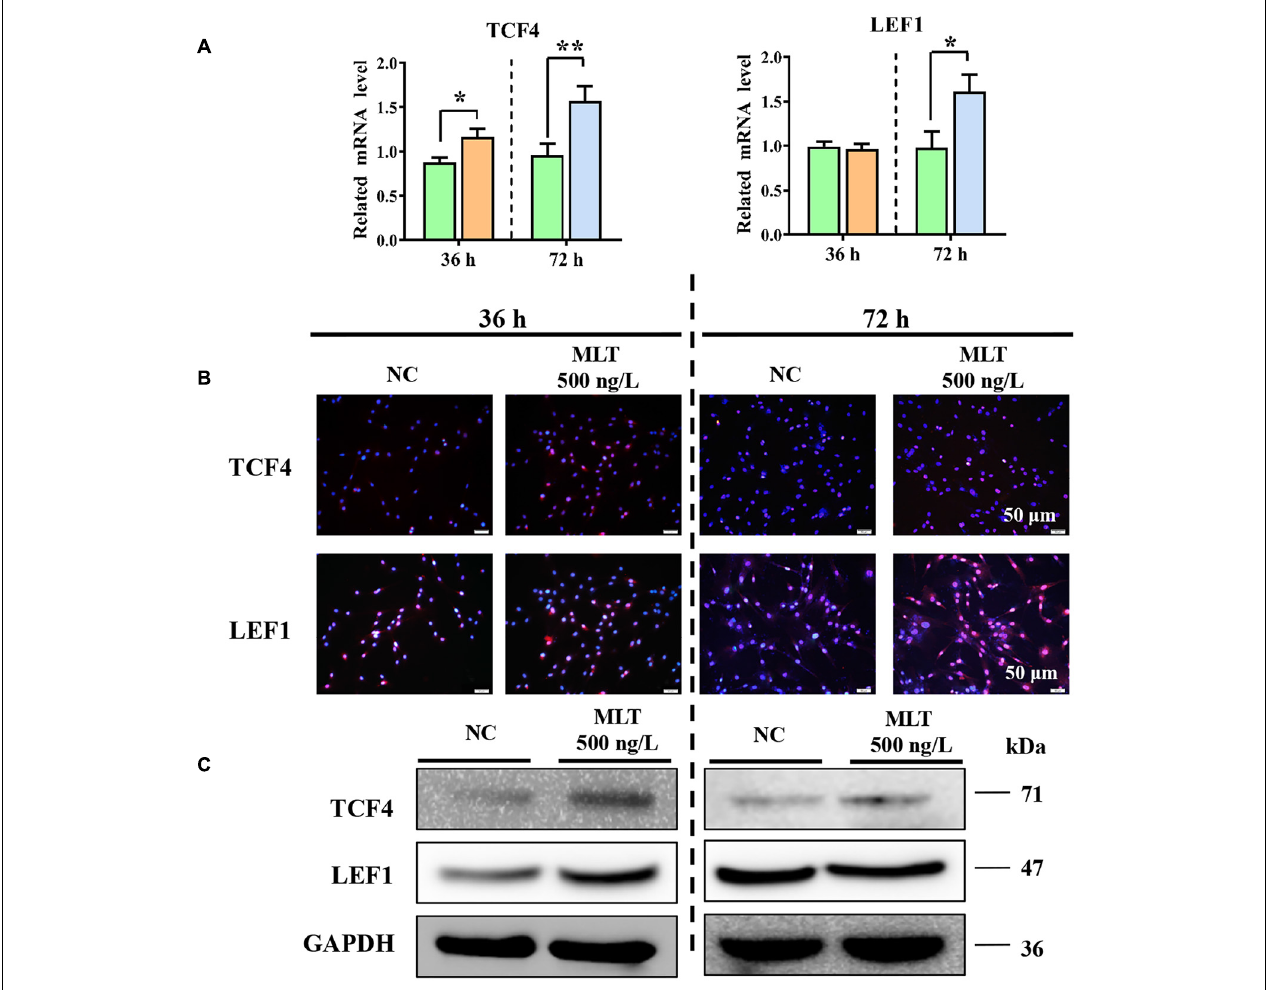
FIGURE 3 | Melatonin promoted the expression of Wnt downstream factors in gsHFSCs. (A) Relative mRNA level of TCF4 and LEF1 as detected by RT-qPCR; ** p < 0.01, * p < 0.05 (Control: green; 36 h melatonin: orange; 72 h melatonin: blue). (B) TCF4 and LEF1 tested by immunofluorescence staining. Scale bar, 50 µ m. (C) TCF4 and LEF1 were compared between melatonin exposed and control cells using Western